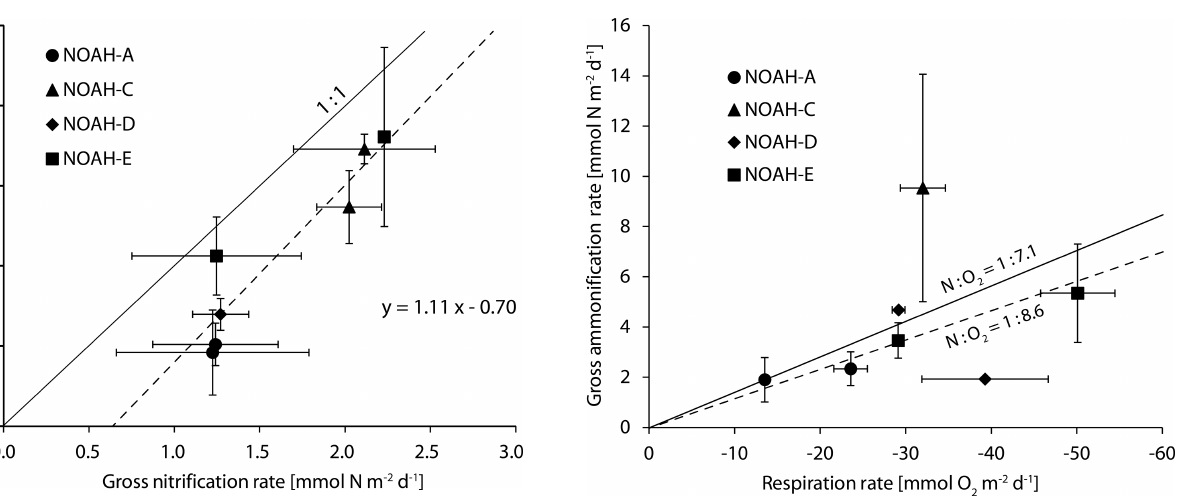
Figure 4. Benthic O 2 fluxes and gross ammonification rates of the sampled stations. The dashed line indicates the Redfield ratio of oxygen to nitrogen (N : O 2 1 : 8625) (Redfield, 1958), and the solid lines indicate the ratio of oxygen to nitrogen determined by the C / N ratio in the North Sea (N : O 2 – 1 : 7 . 1). The error bars indicate the regression error of individual rates at the 0.95 confidence